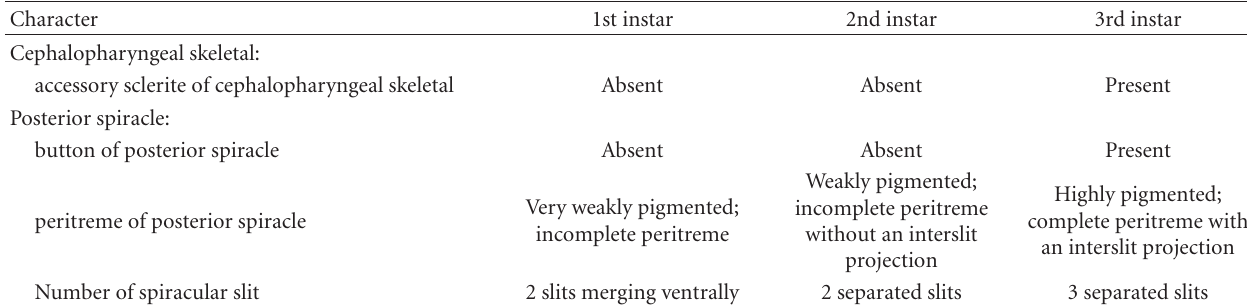
Figure 2: Cephalopharyngeal skeletons and posterior spiracles of Hemipyrellia ligurriens larvae . Cephalopharyngeal skeletons of (a) 1st instar, (b) 2nd instar, (c) early 3rd instar,. and (d) late 3rd instar. Posterior spiracles of (e) 1st instar, (f) 2nd instar, (g) early 3rd instar, and (h) late 3rd instar. Bars = 100 µ m for all figures.